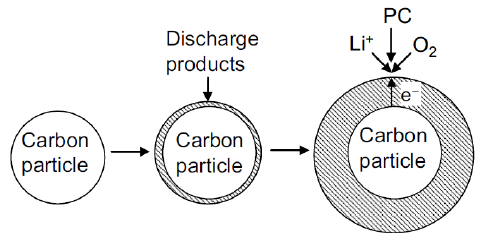
Figure 5. Growth scheme of discharge products on the surface of a spherical carbon particle in a positive porous electrode. Republished from Albertus et al. [9] with permission of the Electrochemical Society, conveyed through Copyright Clearance Center, Inc.